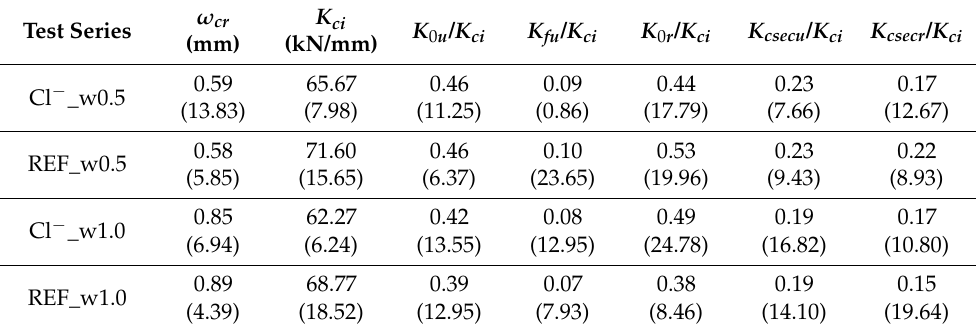
Figure 9. Stiffness parameters determined for each pre-cracked panel using the obtained experi- mental data. Table 5. Average results (and CoV) of normalized stiffness parameters.